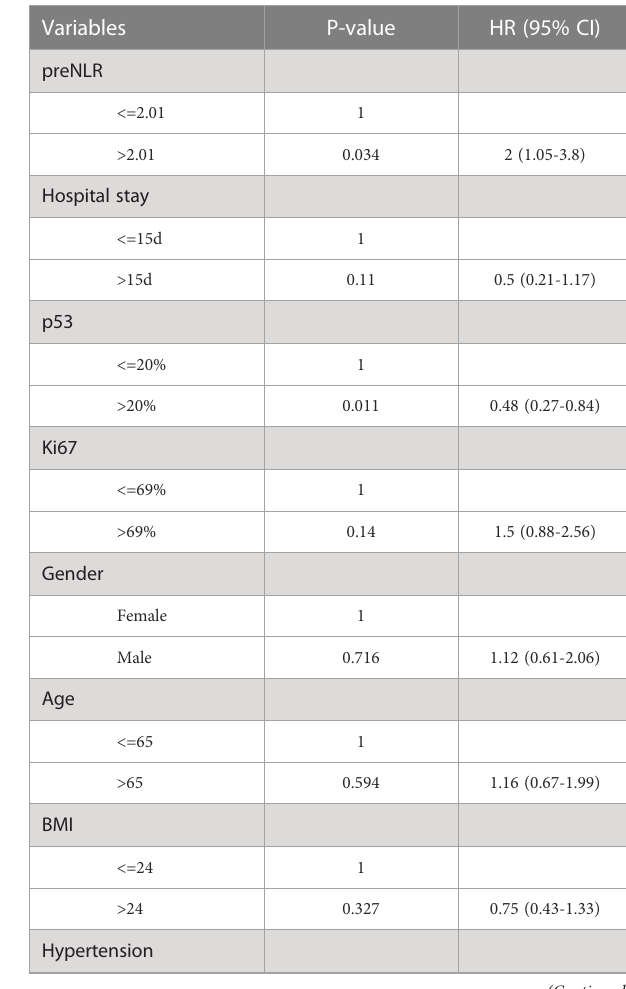
TABLE 2 Univariate Cox regression for